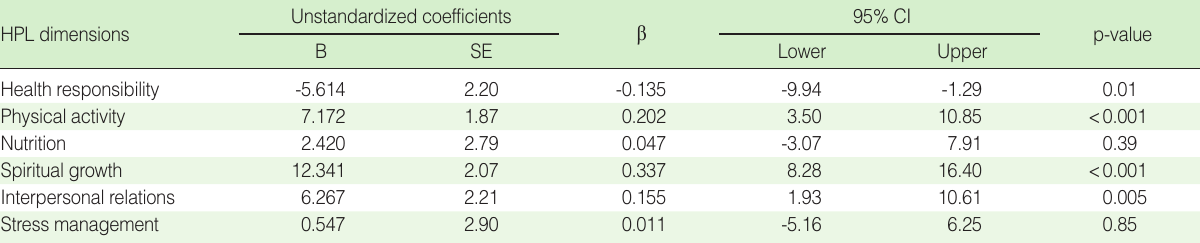
Table 5. Predictive factors of quality of life adjusted for demographic characteristics 1 among the participants according to a multilevel linear regression